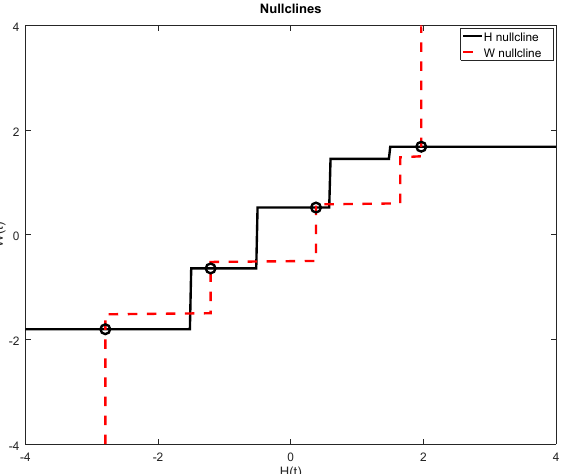
Figure 3. Piece-wise constant influence functions, scenario 2. Plot of H and W vs. time for the deterministic case and a stochastic realization ( top ) and a plot of the nullclines and the equilibrium points ( bottom ).